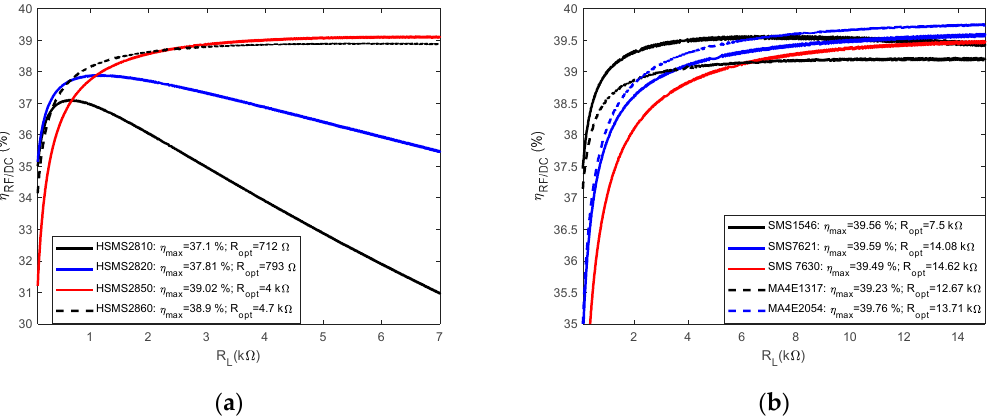
Figure 7. Optimal loads of commonly used diodes. ( a ) Avago diodes. ( b ) Skyworks and Macon diodes.